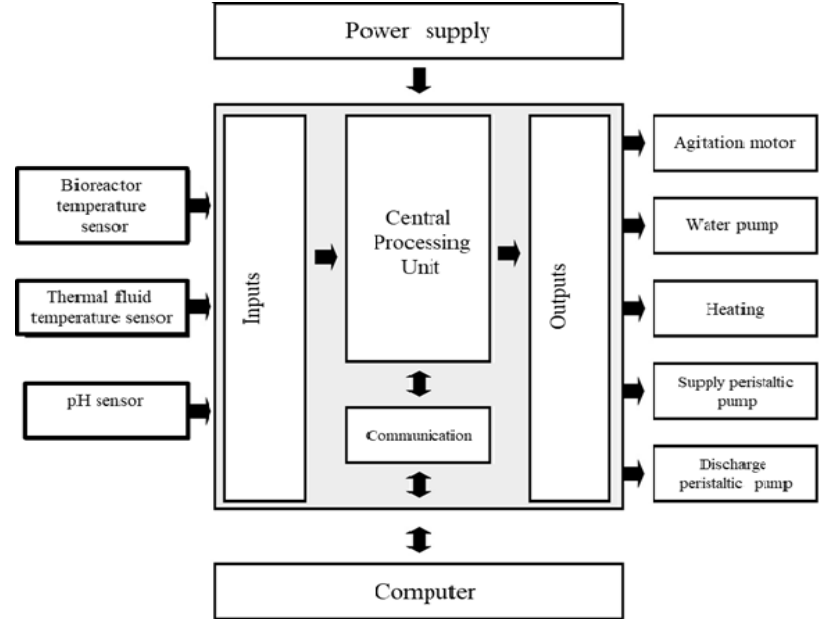
Figure 2. Programmable Logic Controller Scheme. Source: elaborated by the author.